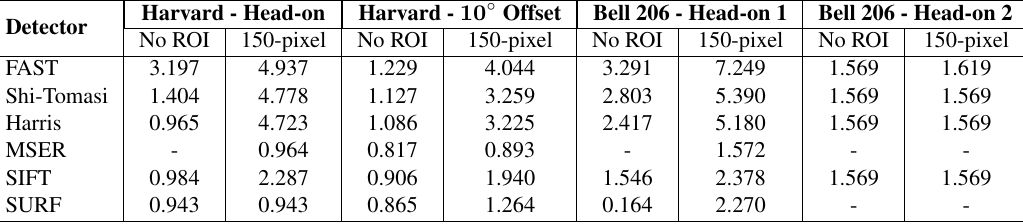
Table 4: The range at earliest detection, R det , with and without a weighted ROI Mask. Each row indicates an R det value kilometres for that feature detector. Columns indicate the datasets, evaluated with and without the ROI mask. A Gaussian PDF with a half-width of 150-pixels was used to generate the